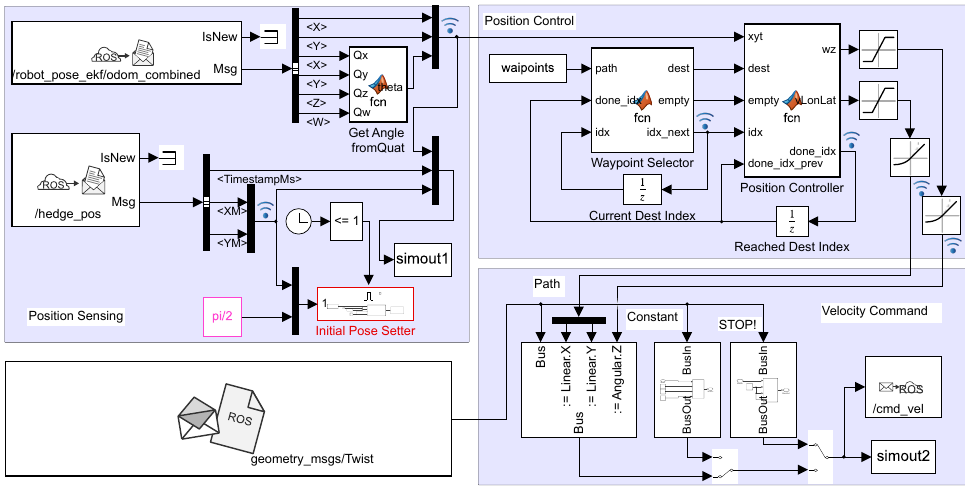
Figure 4. ROS application node implemented in Matlab with odometry initialization from the